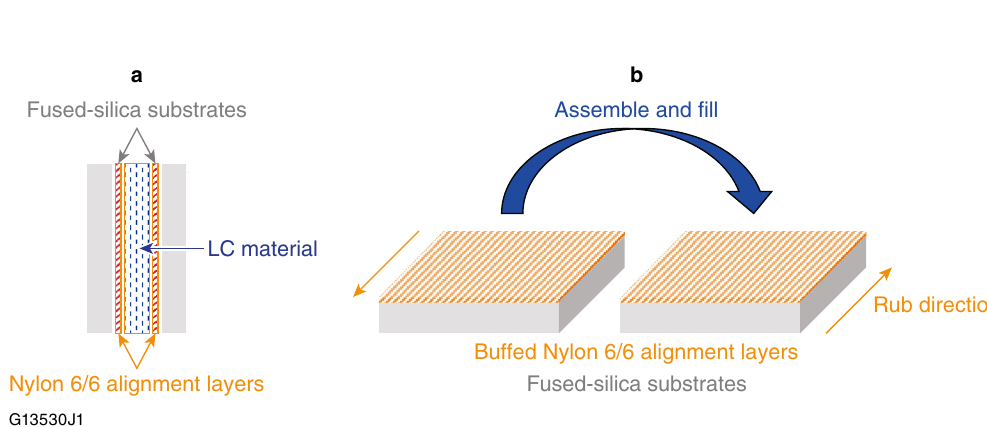
Table 1. Composition, properties and applications of LC mixtures used in the LIDT studies. CB-15 (EM Chemicals) was used as the chiral dopant in the chiral-nematic mixtures. CCH Cyclocyclohexane, PCH Phenylcyclohexane, CB Cyanobiphenyl.